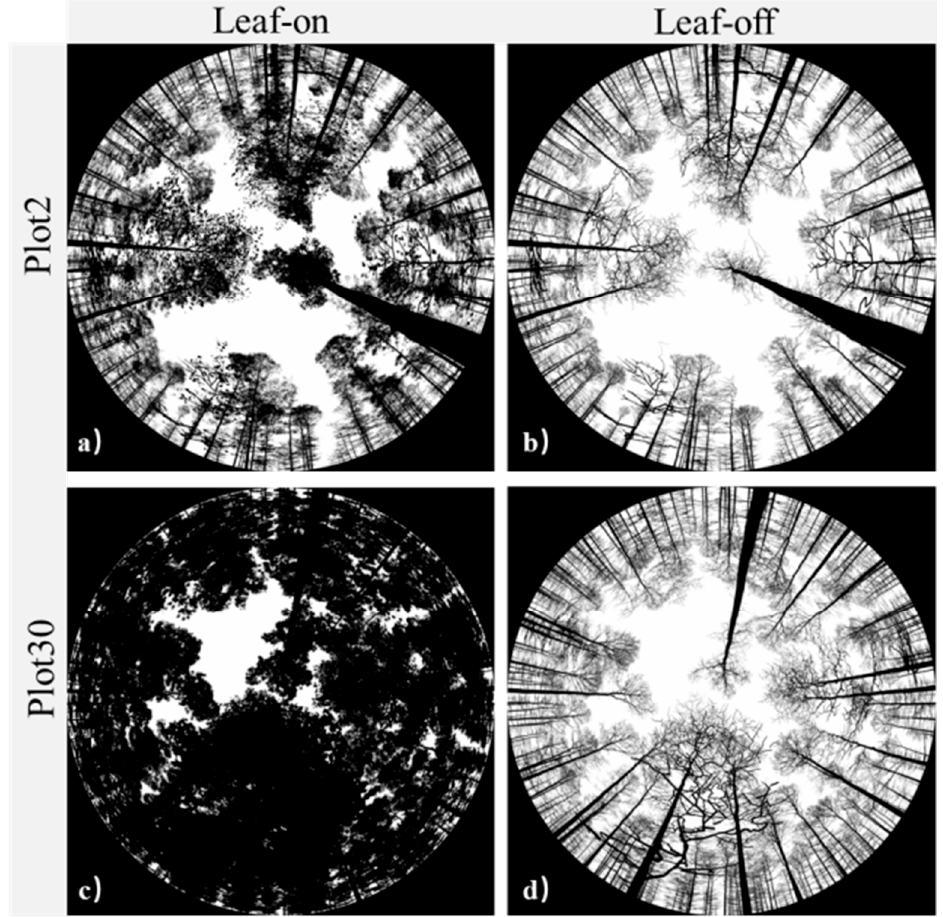
Figure 4. The plot extent and the DHP acquisition locations inside the virtual forest.